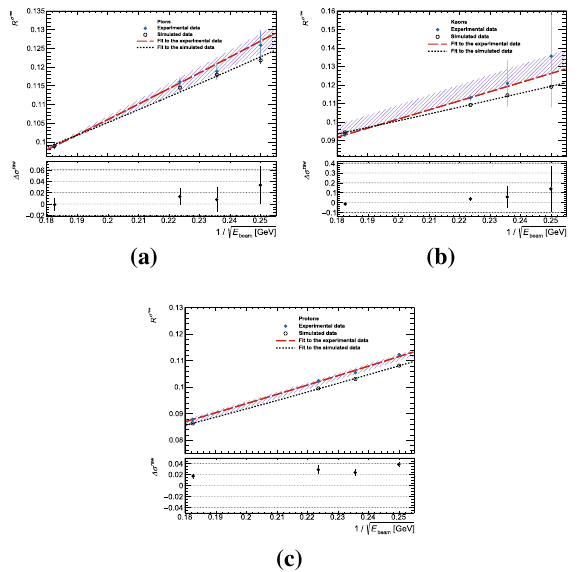
Fig. 21 Energy resolution normalized to incident beam energy, R σ raw , measured (blue circles) and predicted by MC simulation (black circles) √ E beam obtained in the case of pion ( a ), kaon ( b ) as a function of 1 / and proton ( c ) beams. The experimental uncertainties include statistical and systematic effects combined in quadrature. Only statistical uncer- tainties affect simulated results. The red dashed (black dotted) curves are fits of the Eq. (30) to the experimental (simulated) data points. In case of experimental determinations the dashed blue hashed bands were obtained by using the correlated systematic uncertainties. In the bottom of the histograms are shown the fractional differences Δσ raw defined in Eq. (13). The uncertainty includes statistical and systematic effects combined in quadrature